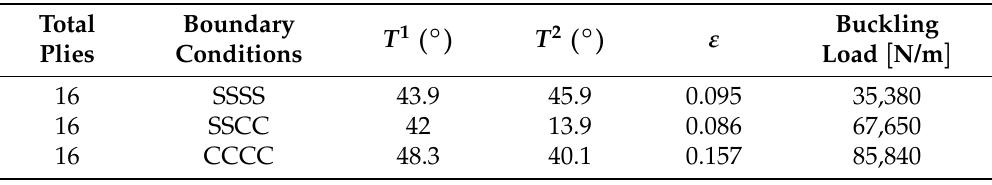
Table 4. Optimization results of straight fiber panels subjected to a biaxial compression plus shear load.